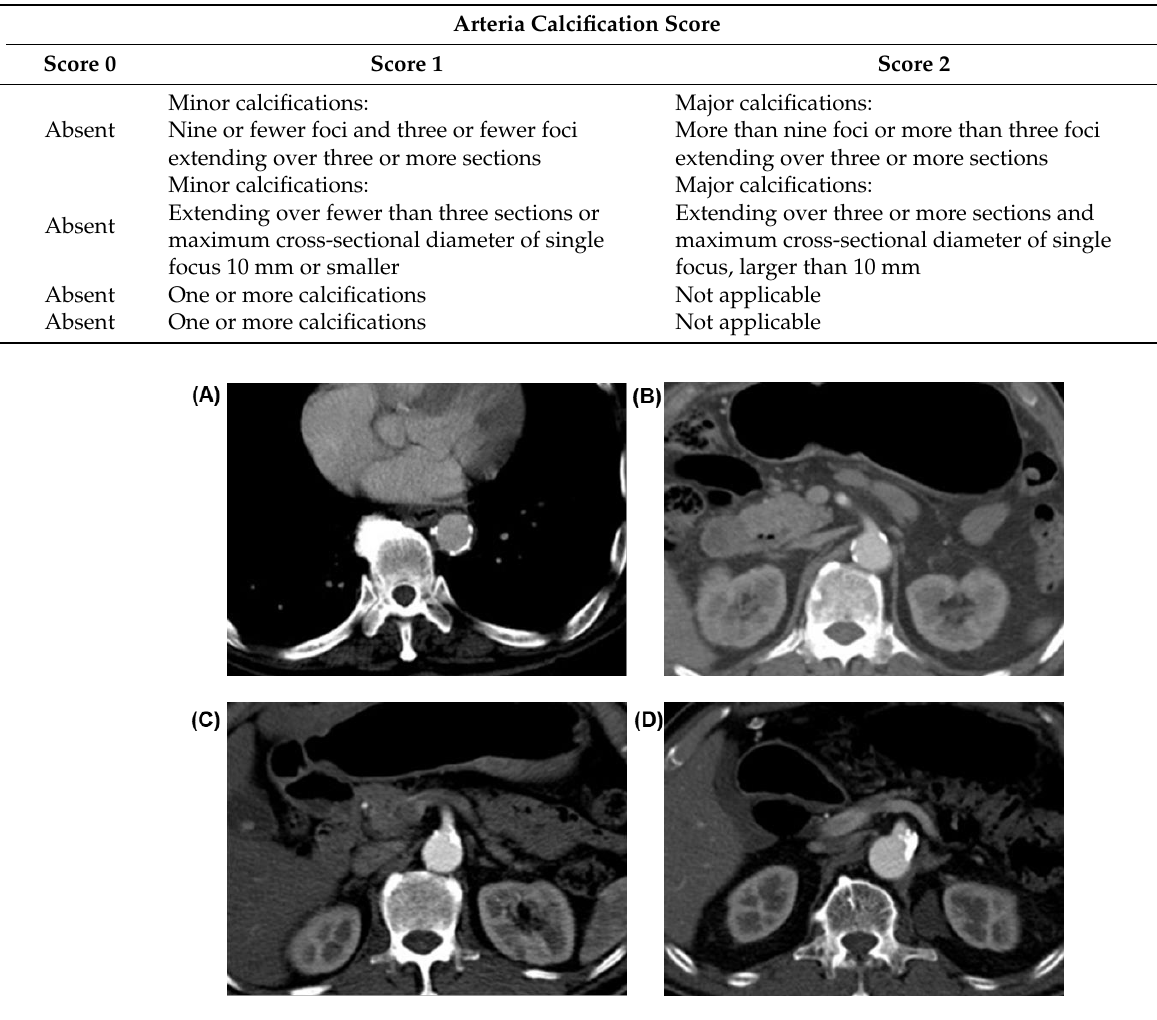
Figure 1. Examples of image characteristics of different grades of aortic and SMA calcifications ( A ) aorta/score 2, ( B ) superior mesenteric artery (SMA)/score 1, ( C ) SMA/score 2 and ( D ) SMA/score 2.